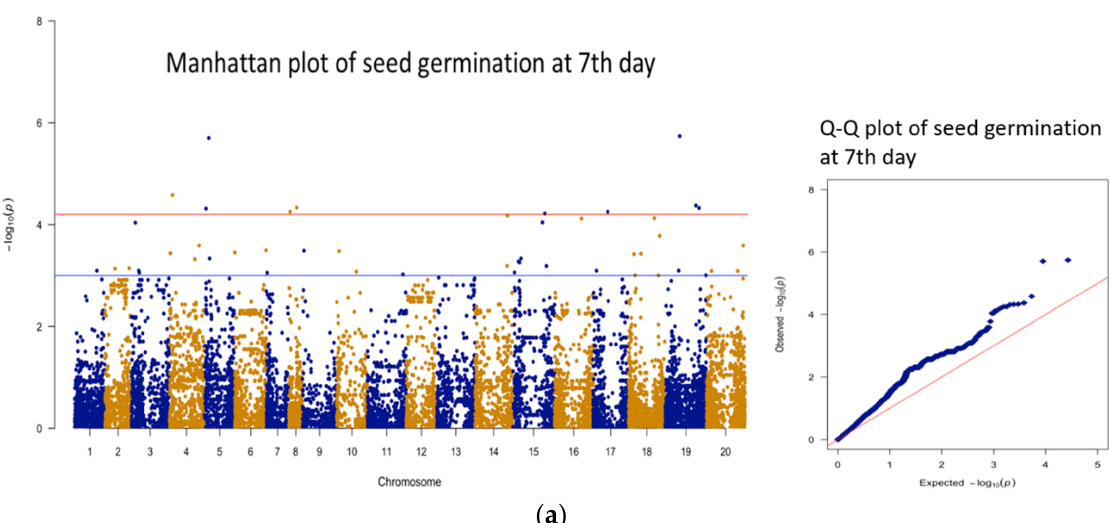
Figure 2. Population structure analysis using membership probability (Q-values) for 120 peanut genotypes. ( a ) Bar plot for different possibility of subpopulation K = 2 to 4 was created with each color representing one cluster. ( b ) Delta K ( Δ K) calculated between K = 2 to K = 9 using information from STRUCTURE analysis indicates that there are two major subpopulations (K = 2).